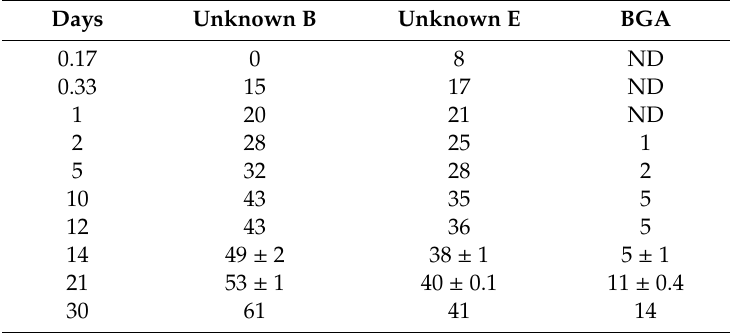
Table 3. Concentrations of the tracked migrants from acrylic–phenolic coatings into 50% ethanol food simulant during the migration test at 60 ◦ C. Results expressed in µ g / dm 2 . ND: not detected.